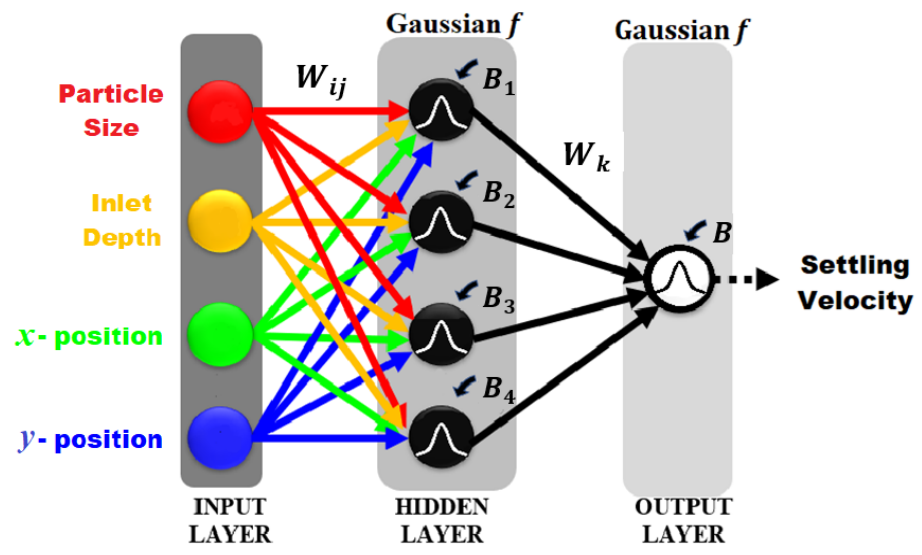
Figure 3. Network architecture of the proposed